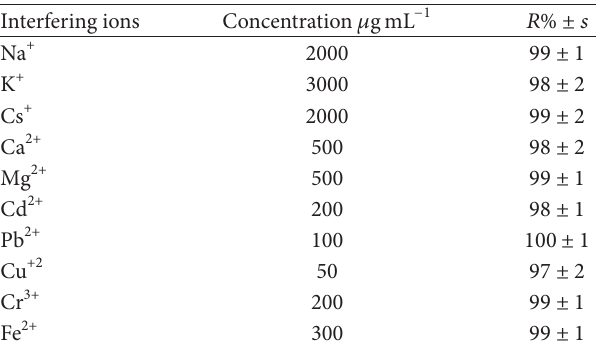
T 1: e tolerance limit of the diverse ions on the determination of gold.